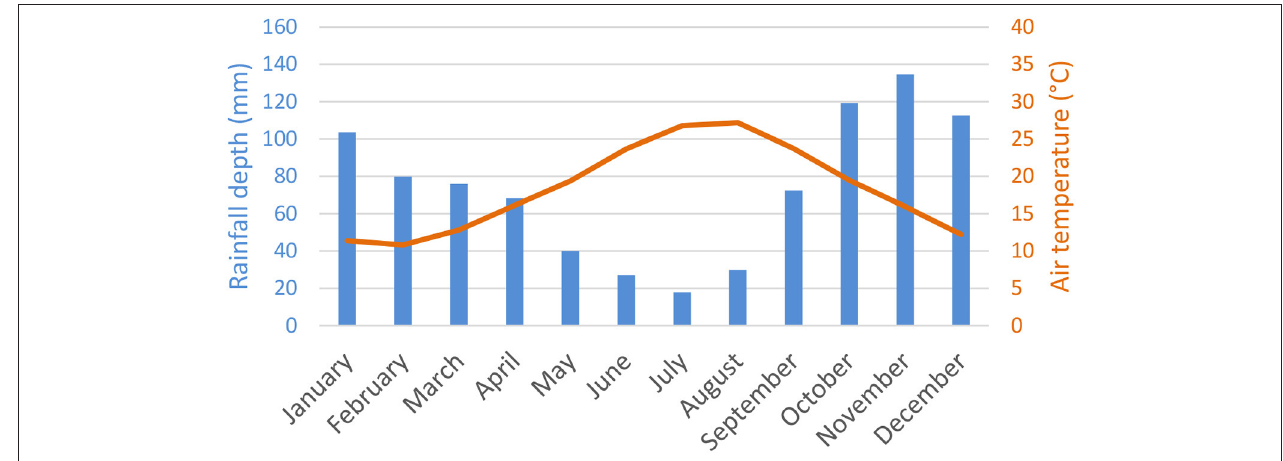
FIGURE 2 | Average monthly rainfalls and temperatures related to the Pozzuoli area for the 1970–2014 time